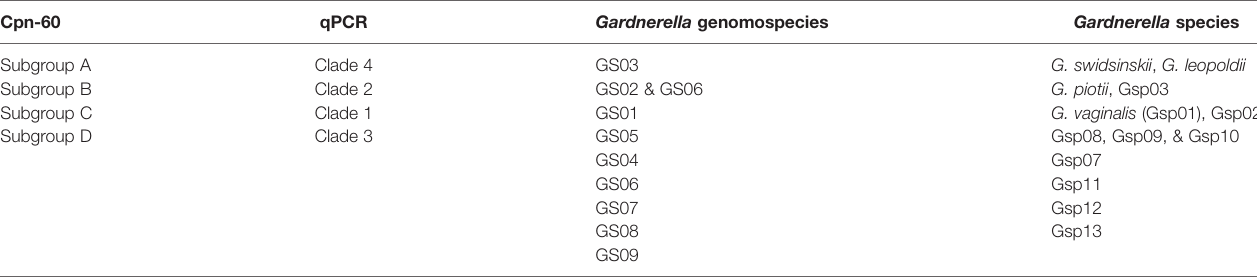
TABLE 1 | The relationship between different Gardnerella